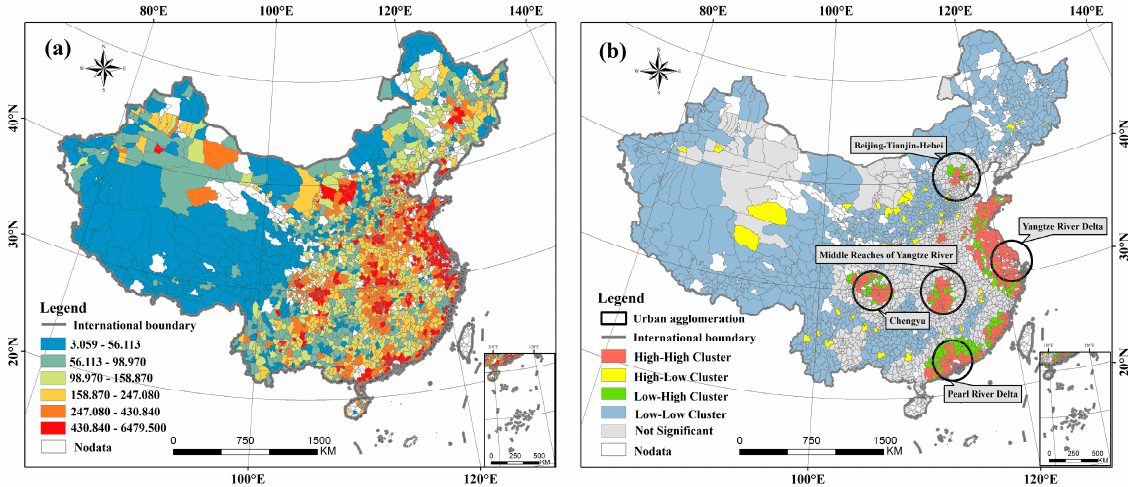
Figure 2. Spatial distribution pattern of county economies in China: ( a ) The spatial distribution of GDP in China at the county level; ( b ) the spatial clustering results of GDP in China at the county level.